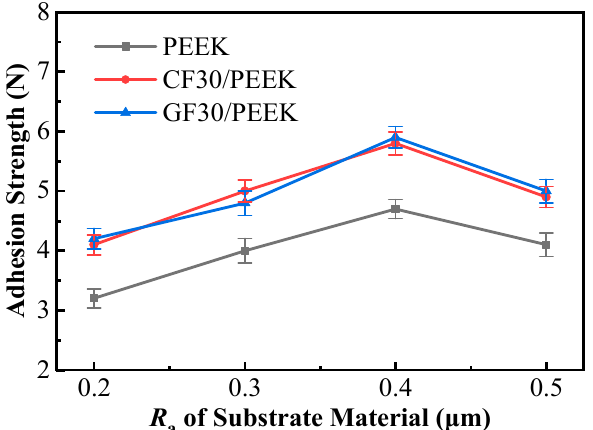
Figure 7. Comparison of experimental results of different materials and surface roughness.